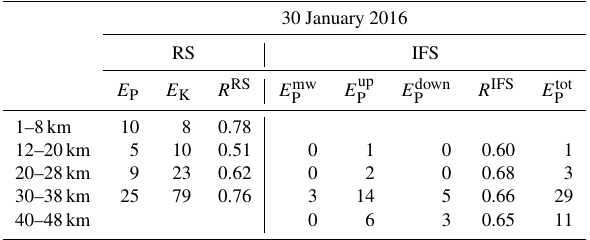
Table 1. Kinetic and potential energy densities E K (m 2 s − 2 ) and E P (Jkg − 1 ) for the 30 January 2016 09:08UTC radiosonde sound- ings (RSs). Additionally, the ratio R RS of the power of the upward- propagating part of the rotary spectrum to the total power is given. Mean gravity wave potential energy densities in Jkg − 1 derived from vertical time series of the IFS temperature perturbations as shown in Fig. 7b. E P values are classified for quasi-stationary